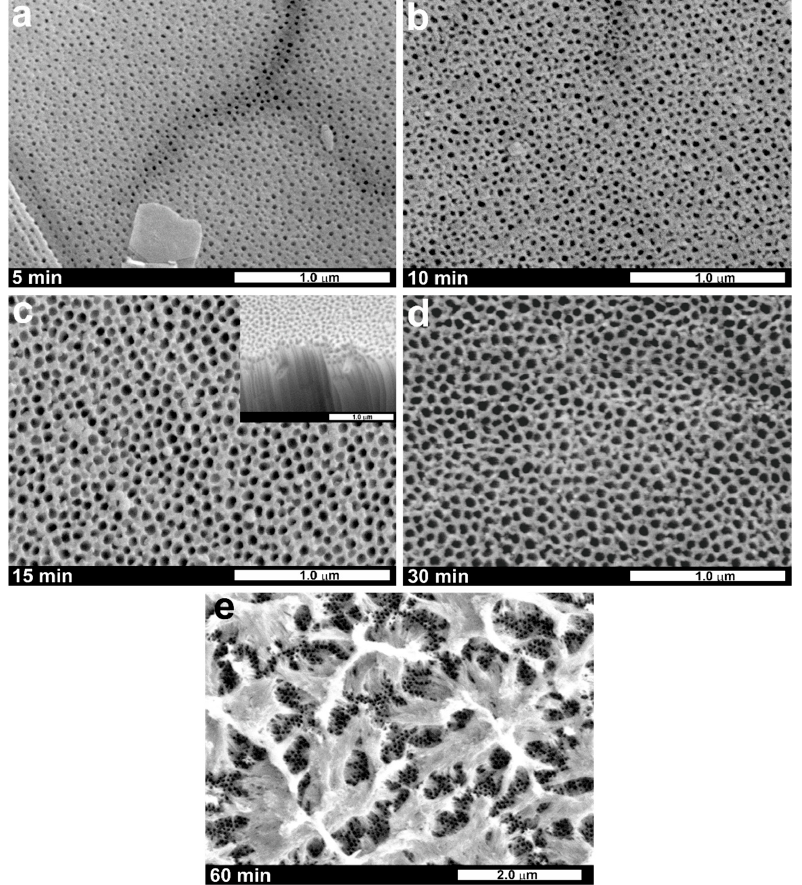
Figure 2. SEM microphotographs of the Ti15Mo alloy anodized in the ethylene glycol-based electrolyte under 40 V for different periods (( a )—5 min, ( b )—10 min, ( c )—15 min, ( d )—30 min, and ( e )—60 min). The inset in ( c ) shows an exemplary cross-section of the obtained oxide layer. Magnification of ( a – d ) was 50.0 k; ( e ) was 20.0 k. As can be seen, the samples anodized for 5–30 min exhibit a uniform nanoporous morphology (Figure 2a–d). In addition, the average pore diameter increased from c.a. 40